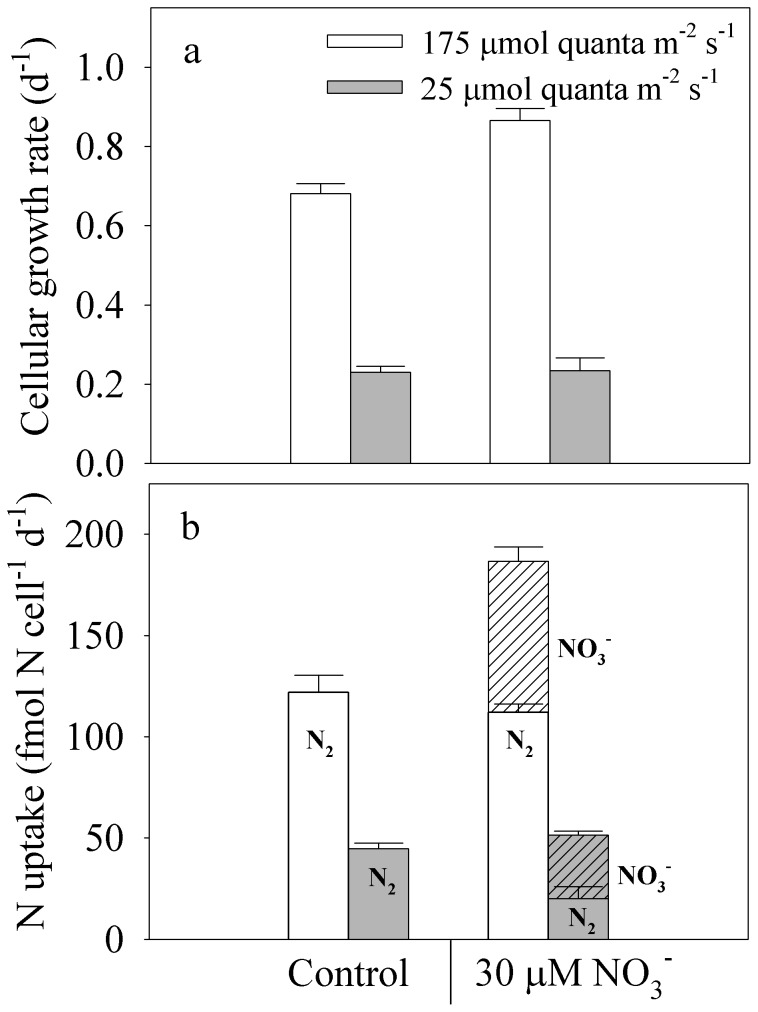
Effects of long-term exposure to 30 µmol L−1 nitrate (NO3
−).(a) cellular growth rates and (b) nitrogen-assimilation rates of Crocosphaera watsonii (WH0003) acclimated to high light (175 µmol quanta m−2 s−1) and low light (25 µmol quanta m−2 s−1). (b) N2-fixation rates (solid bars) are overlain on total N assimilation (N2 + NO3
− assimilation, hashed bars). Control cultures did not receive added NO3
−. Error bars represent standard deviations on means from 3 culture replicates.